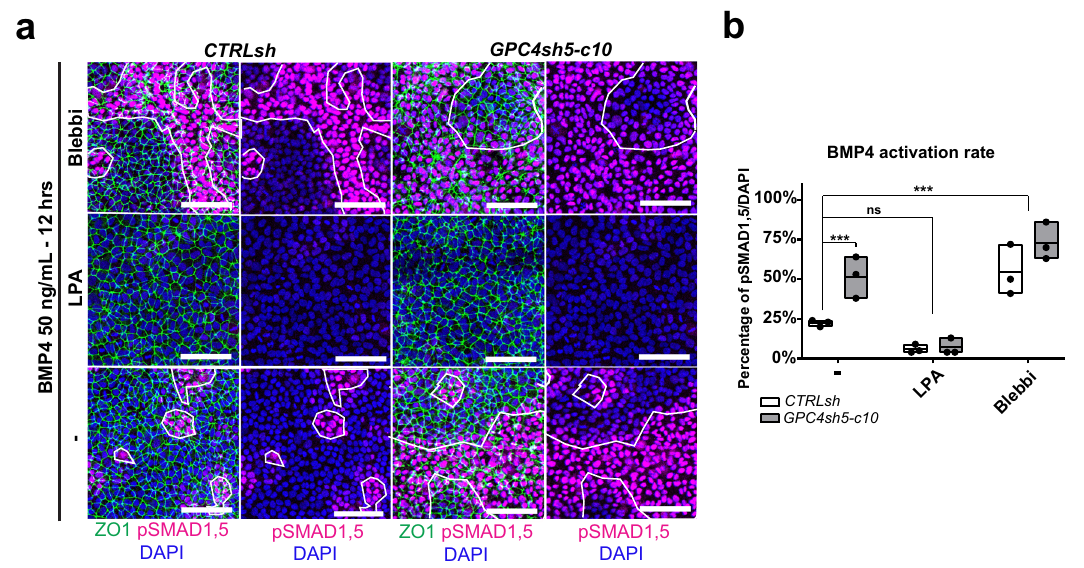
Fig. 9 | Disruption of epithelial integrity prolongs TGF- β signaling activation. a AnalysisofpSMAD1,5and ZO1 expressionincontrolandshGPC4cellsstimulated for 12h with 50ng/mL of BMP4 in the presence of Blebbistatin (Blebbi) and LPA (added 6h after stimulation onset) to impair or promote TJ formation. Cultures were subjected to immuno fl uorescence analysis of pSMAD1,5 (magenta) and ZO1 (green) proteins, n =3. Outlined areas in the overall panels highlight the extent of